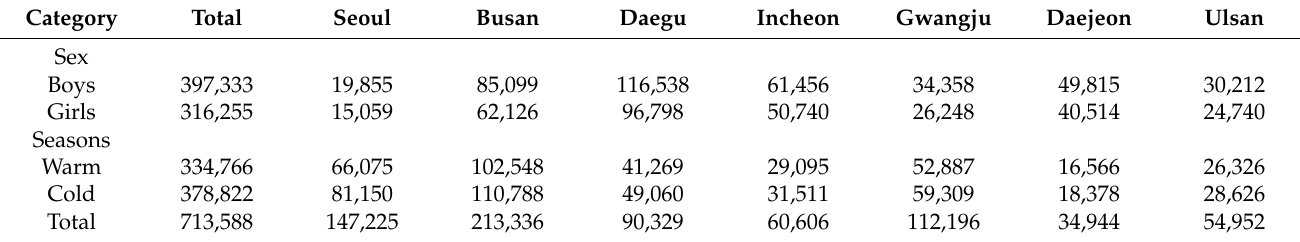
Table 1. Number of acute lower respiratory infection (ALRI) hospitalizations by sex and season for the seven metropolitan cities of Korea from 2008 to 2016. The warm season is April–September and the cold season is January–March,